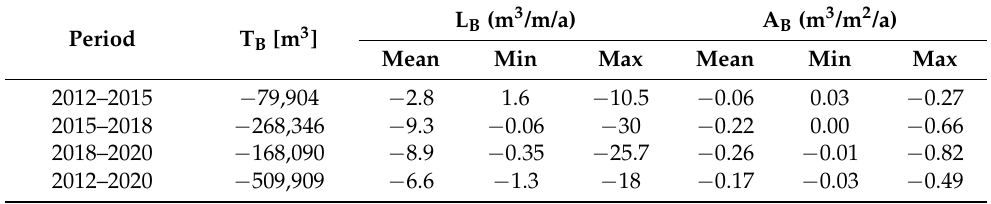
Figure 11. Spatial differentiation of the volume changes of the cliff in the sectors subjected to the greatest erosion in the period 2012–2020. Raw data source—Maritime Office in Szczecin. Raw data source—Maritime Office in Szczecin. Table 6. Sediment losses during the observation periods. Raw data source—Maritime Office in